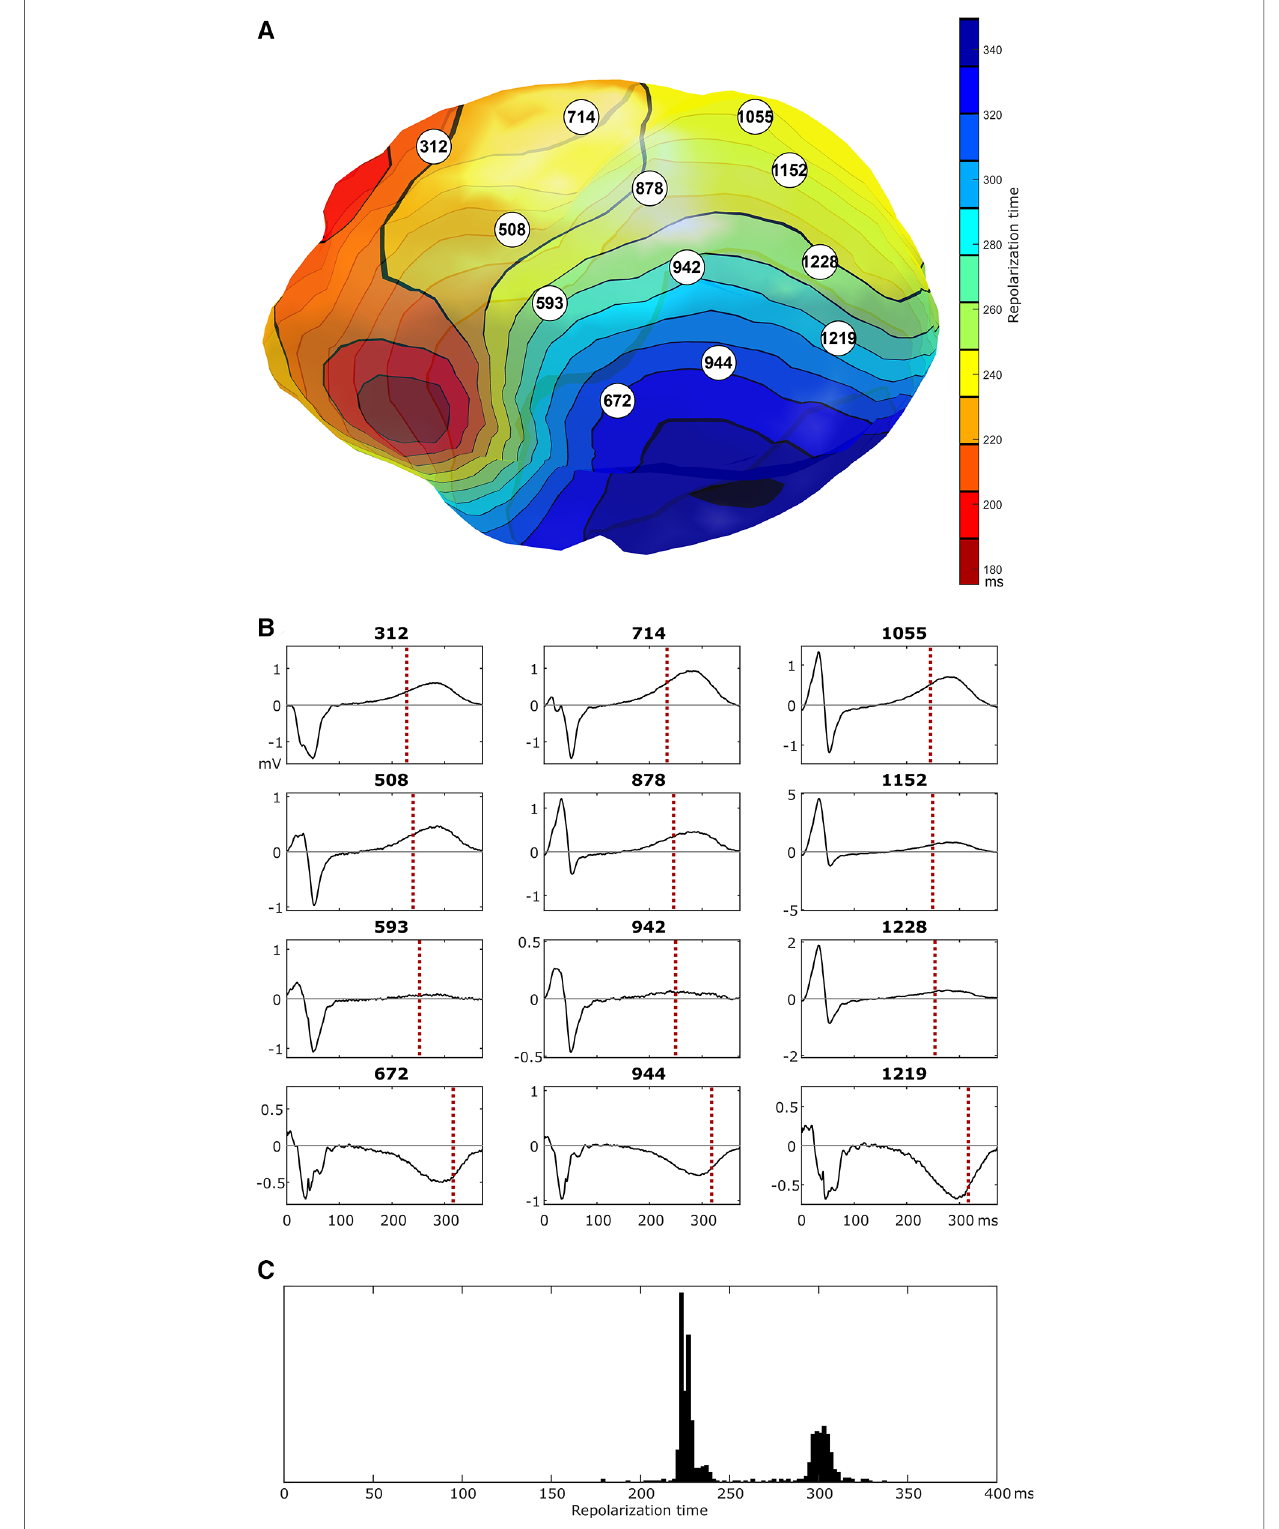
FIGURE 4 Epicardial isochrones of repolarization times [panel ( A )] and selected epicardial electrograms [numbers re fl ect node id, panel ( B )], as imaged with ECGI during a sinus beat. In the region of crowded repolarization isochrones, there is a switch in polarity of the repolarization phase of the local electrogram. Local electrograms show no clear signs of conduction abnormalities (the high-frequency signal in the last row of electrograms is present throughout the depolarization and repolarization phases and may re fl ect powerline interference). Panel ( C ) shows the distribution of repolarization times for all locations on the epicardial ventricular surface, highlighting a distinct region of early repolarization and a distinct region of late repolarization of approximately the same